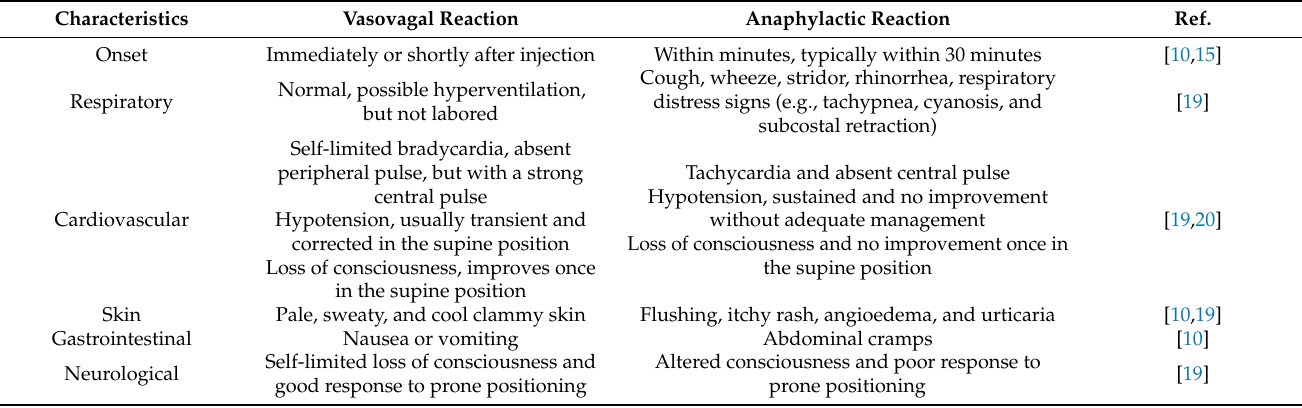
Table 1. Differentiation between vasovagal reaction and anaphylactic